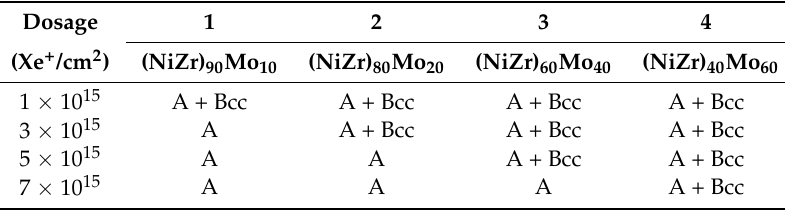
Table 6. Phase transformation for the Ni-Zr-Mo multiple layers upon Xe + beam mixing to different doses [72]. (A: amorphous phase; Bcc: bcc crystalline